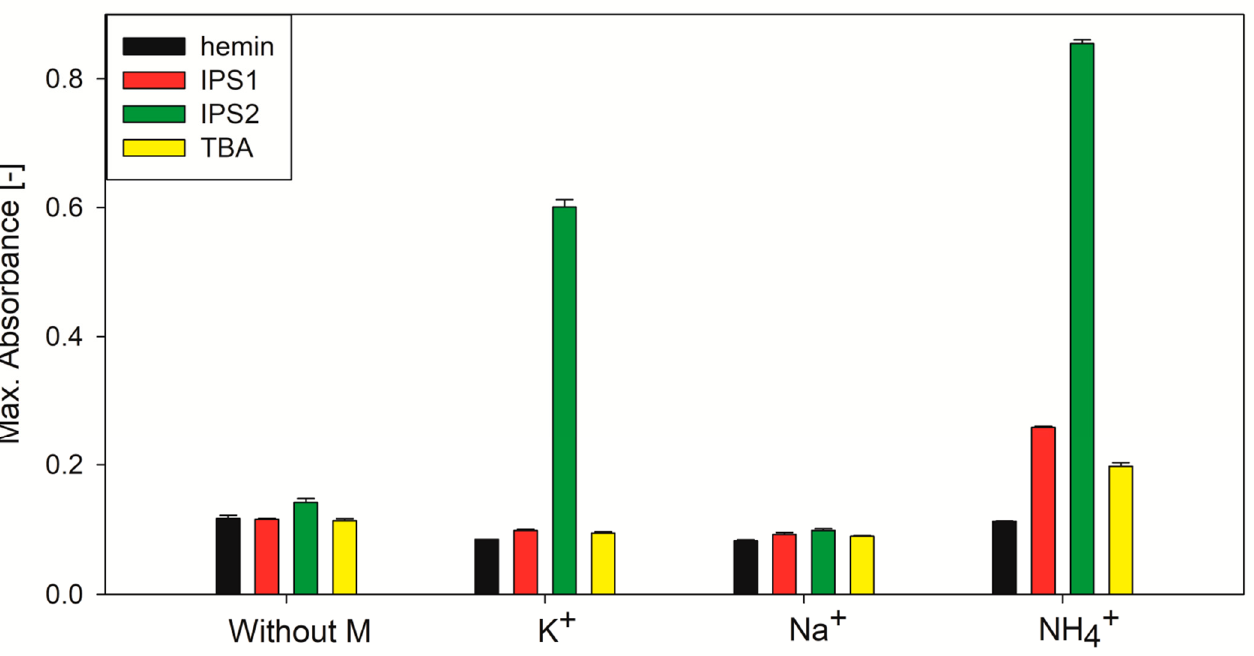
Figure 2. Catalytic activity of DNAzymes in the reaction of ABTS oxidation. Conditions: 10 mM Tris-HCl (pH = 8.0), 100 mM KCl, NaCl or NH 4 Cl, 0.0016% Triton X-100, 1 µM DNA, 1 µM hemin, 1 mM ABTS, 1 mM H 2 O 2 .